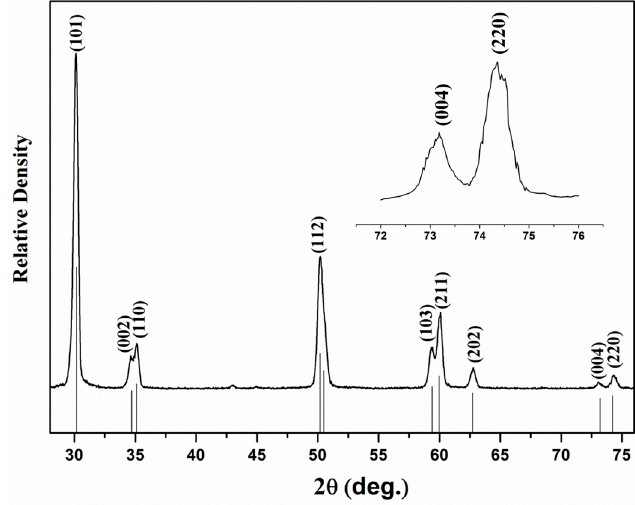
Figure 2. XRD patterns of 3Y-TZP ceramic after HIP treatment.